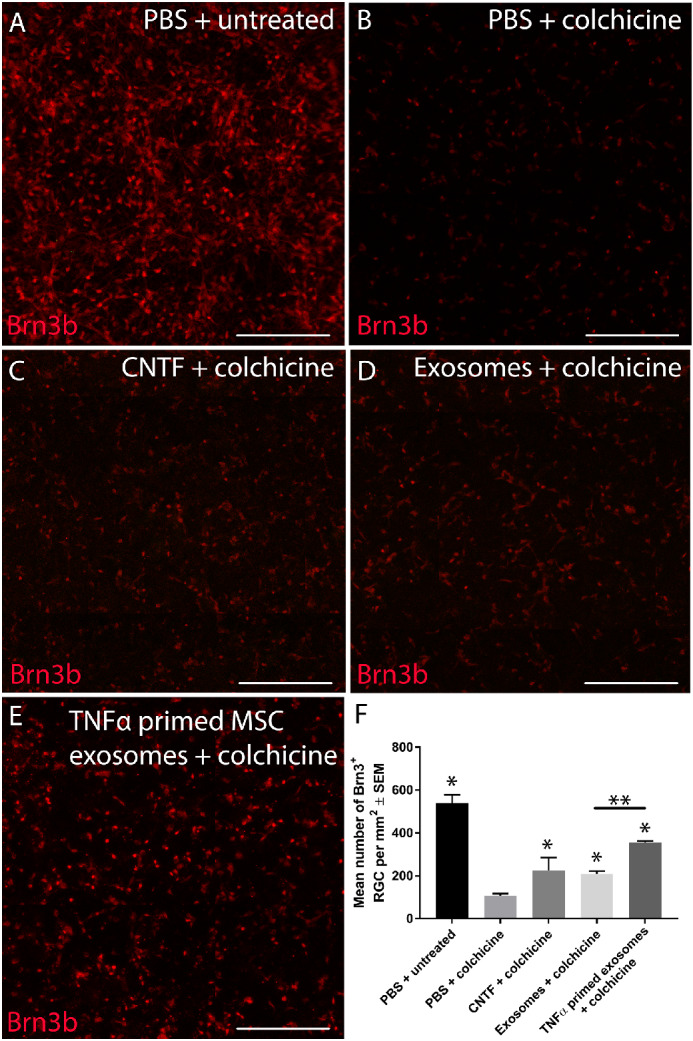
Exosome treatment of heterogeneous human stem cell–derived retinal cultures. Heterogeneous retinal cultures derived from human stem cells were left uninjured/untreated (A), injured with colchicine but untreated (negative control; B), injured with colchicine/treated with CNTF (positive control; C), injured with colchicine/treated with MSC exosomes (D), or injured with colchicine/treated with TNFα primed MSC exosomes (E; scale bar: 250 µm). The number of RGCs (F), identified by the Brn3b expression, were quantified (n = 3). Asterisks indicate significant difference from untreated/colchicine-injured control at P < 0.05). Asterisks also indicate a significant increase in RGC neuroprotection in comparison to untreated/colchicine-injured control (P < 0.05) and include CNTF treatment, exosome treatment, and TNFα primed exosome treatment. Furthermore, significant difference was also observed between exosome treatment and TNFα primed exosome treatment (double asterisks).